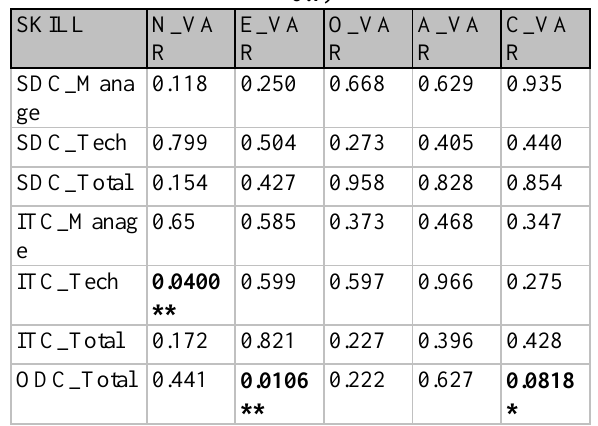
Table 5. P value of t-test for team variance personality and learning effectiveness ( **: P value < 0.05 , *: P value